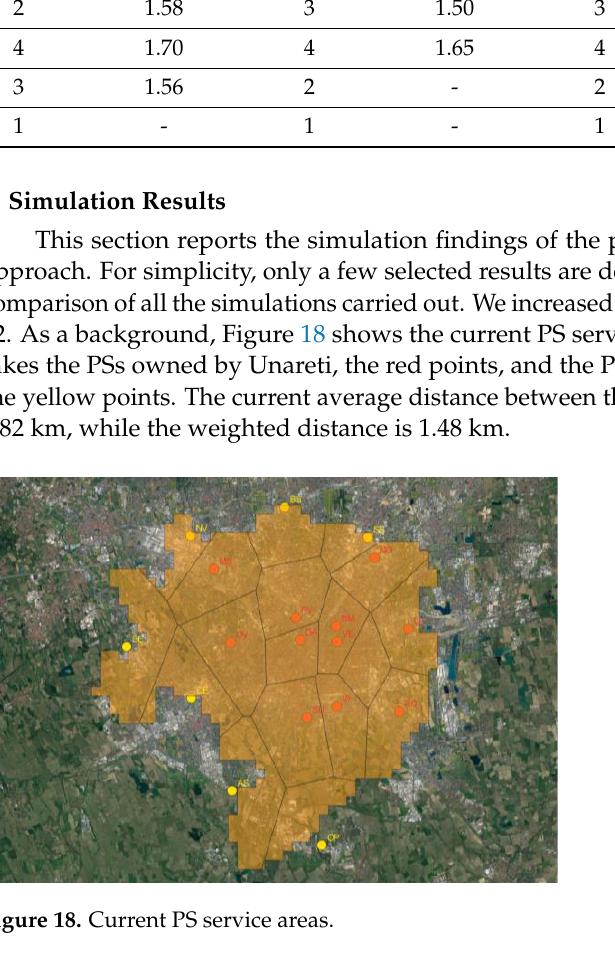
Figure 19. Output of the simulation results considering three new PSs. Blue points are the new PSs, while gray is the existing ones. The restricted number of PSs concerning the Milan and Rozzano area does not allow installing any PSs on the left-hand side of the map, whose squares remain far from the related PSs. The PS service areas are better highlighted in Figure 20. The new PS called “ 1 ” split the service area of the existing PS called “ SU ” almost by half, giving undoubted advantages in reducing the distance between squares and the related PSs. The cells ’ colors show that the algorithm does not fail in finding a feasible solution, which guarantees a power demand of the PSs lower than 75% of the transformers ’ nominal power. Neverthe- less, five PSs out of fourteen have a loading greater than 50%, reporting potential critical- ities in dealing with additional future power demand increases. It is worth noticing that the PS “ OV ” service area still has a significant extension.